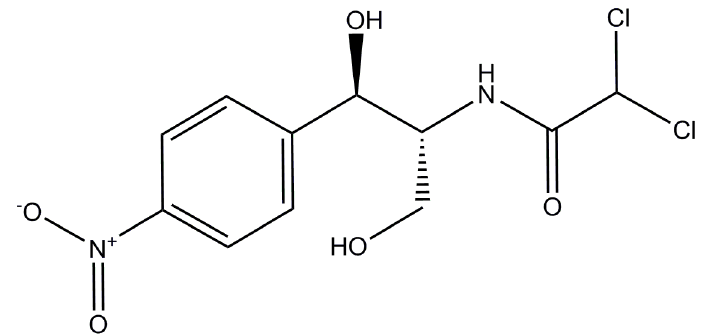
Figure 1. Molecular structure of CAP.